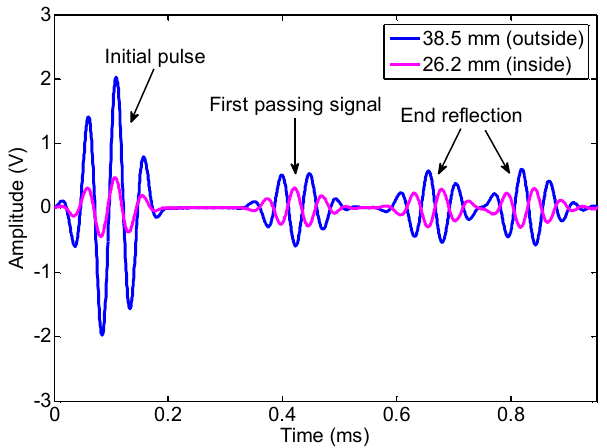
Figure 8. The signals induced by the internal coil with a 26.2 mm diameter and the external coil with a 38.5 mm diameter at 20 kHz.